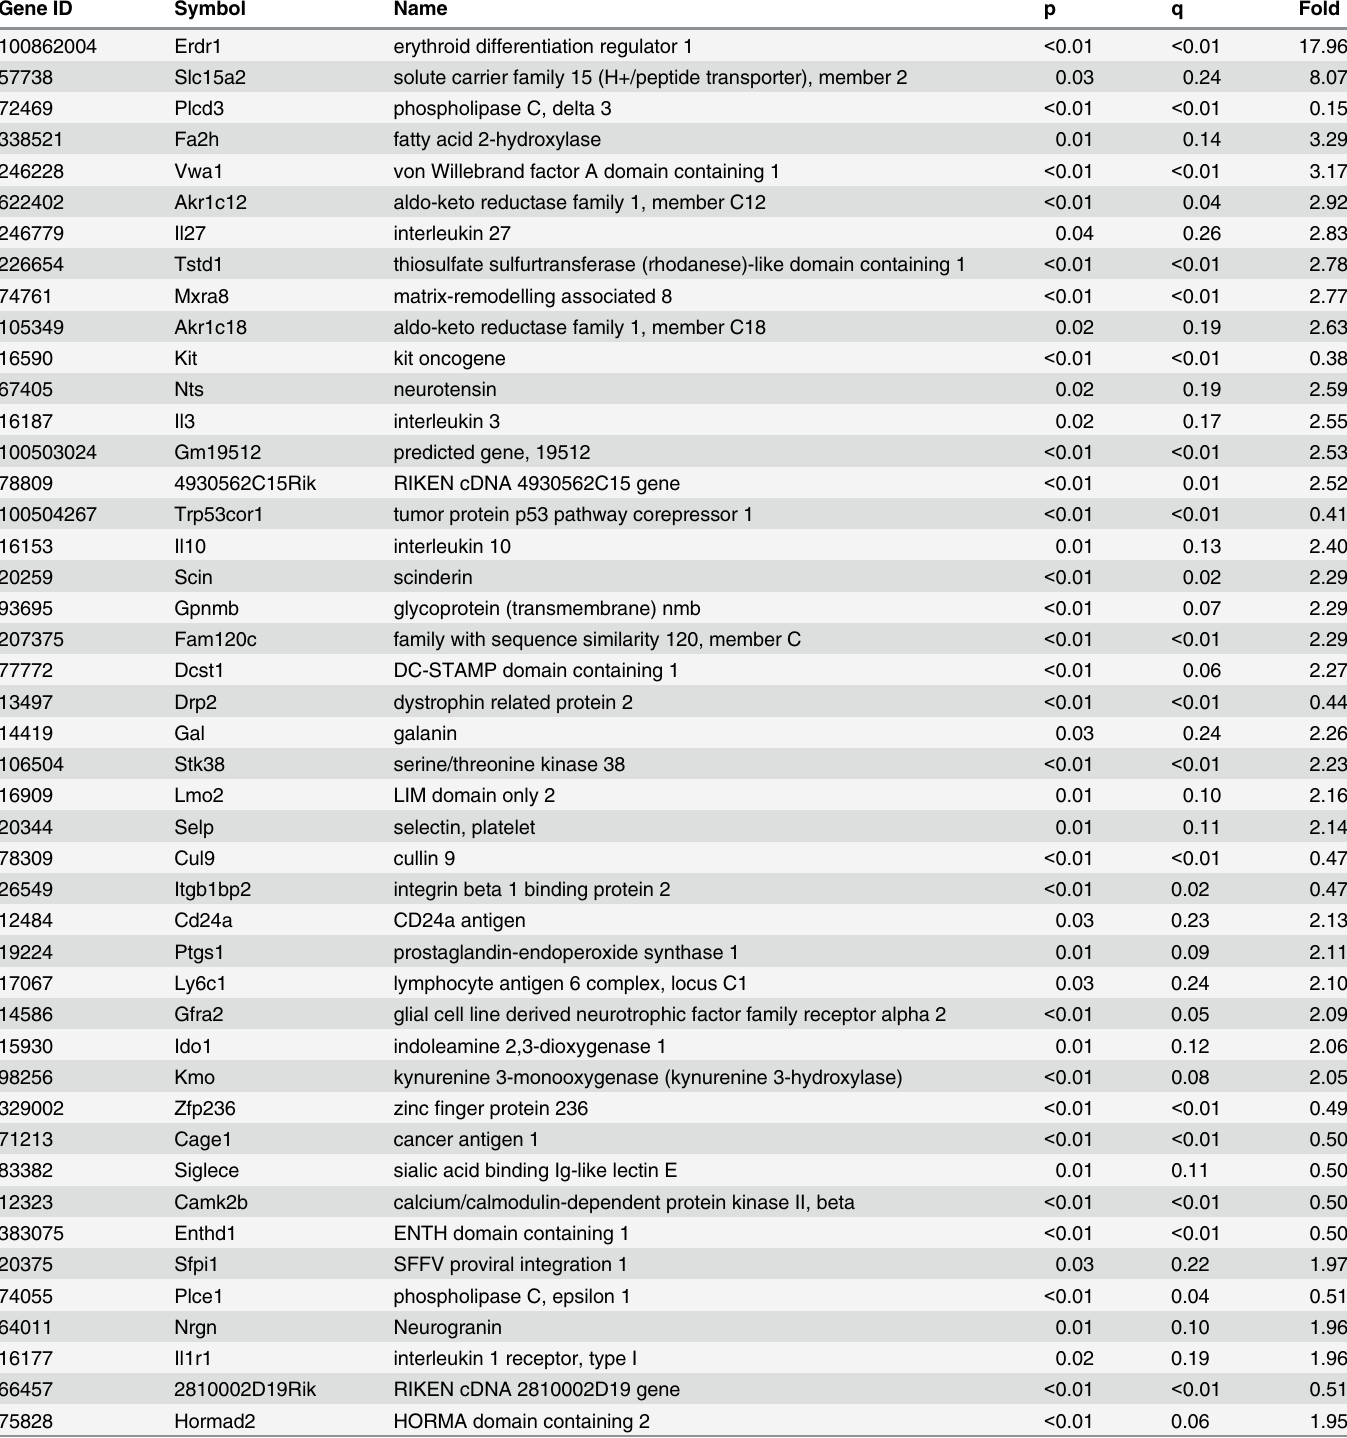
Table 1. Top 50 RNA-Seq significantly different genes sorted by magnitude of fold change (KO/CTL). The official symbol of the top 50 (significant) genes found via RNA-Seq are given, along with fold change (KO/CTL), raw p-value for differential expression, and q (false discovery rate value based on method of